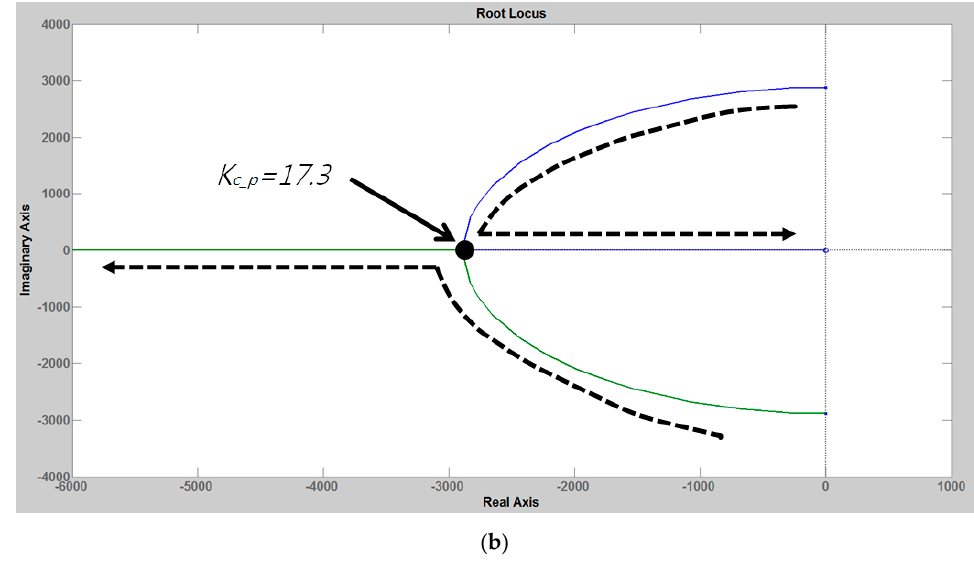
Figure 3. Block diagram and root locus of the inner current control loop: ( a ) block diagram; ( b ) root locus.